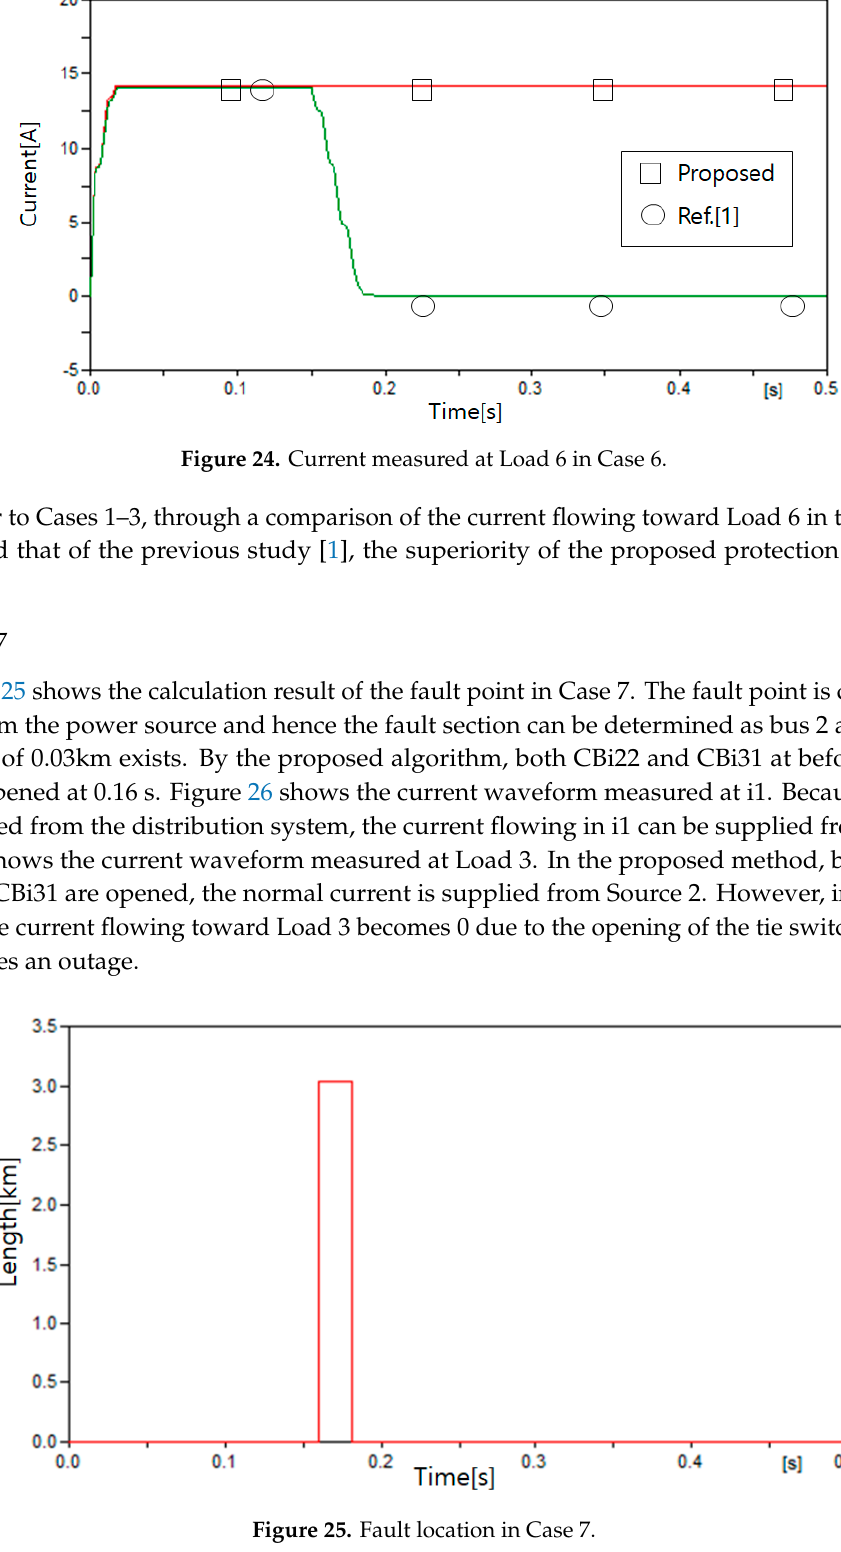
Figure 23. Current measured at I 2 in Case 6.